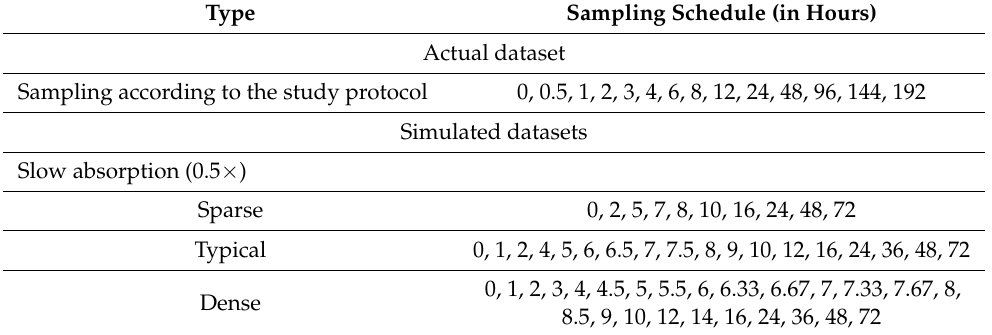
Table 2. Sampling schedules used in the analysis. The sampling schedule for the actual data was the one reported in the study protocol. For the simulated datasets, the “typical” sampling scheme for each absorption kinetic type was designed to characterize the C-t profile appropriately using an optimum number of samples. Sparse designs were developed by omitting sampling points, usually one by one. Dense designs were created by adding sampling